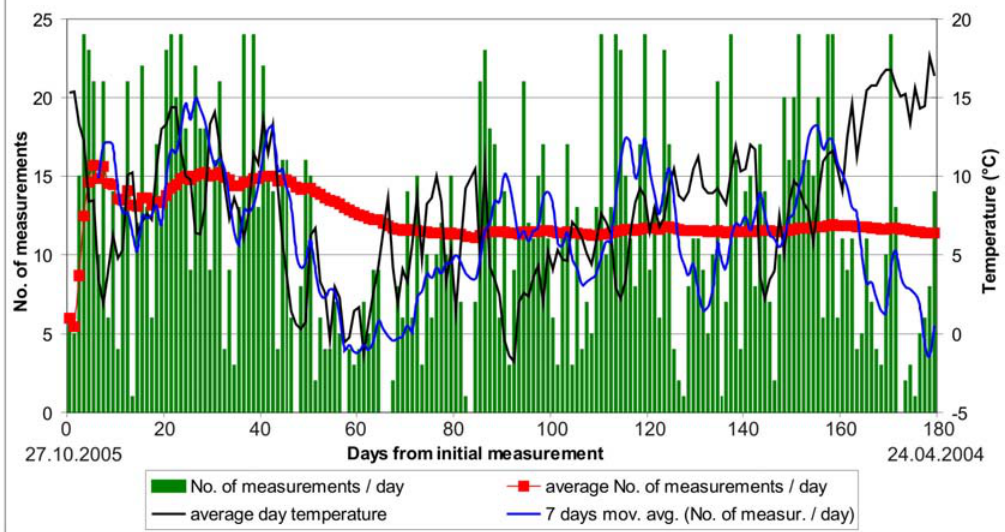
tunnel with plotted average measurement rate and average day temperature in